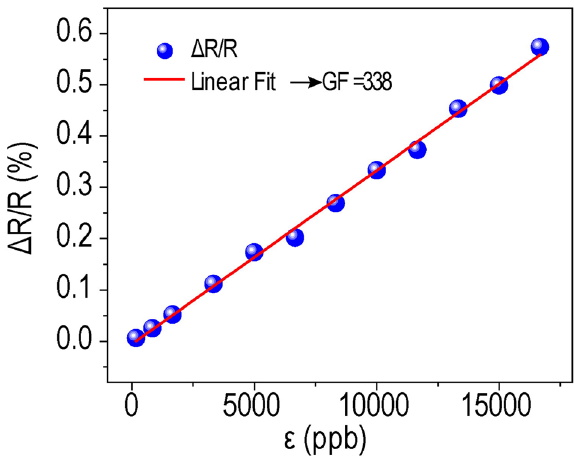
Fig. 3 Normalized resistance change as a function of external strain, demonstrating a GF of 338